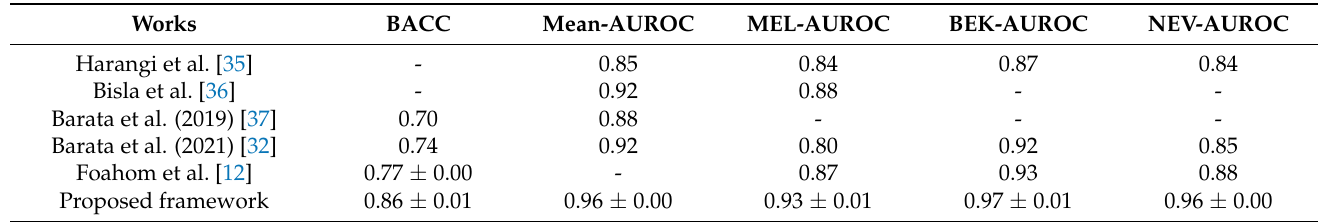
Figure 1. Receiver operating characteristic (ROC) curves obtained with our framework. The Area under the curve (AUC) of the ROC is given for each lesion class: Melanoma (MEL), Benign Keratosis (BEK) and nevi (NEV) on the test set. Table 1. Comparison with existing CAD system for the multi-class classification of Melanoma, Nevi and